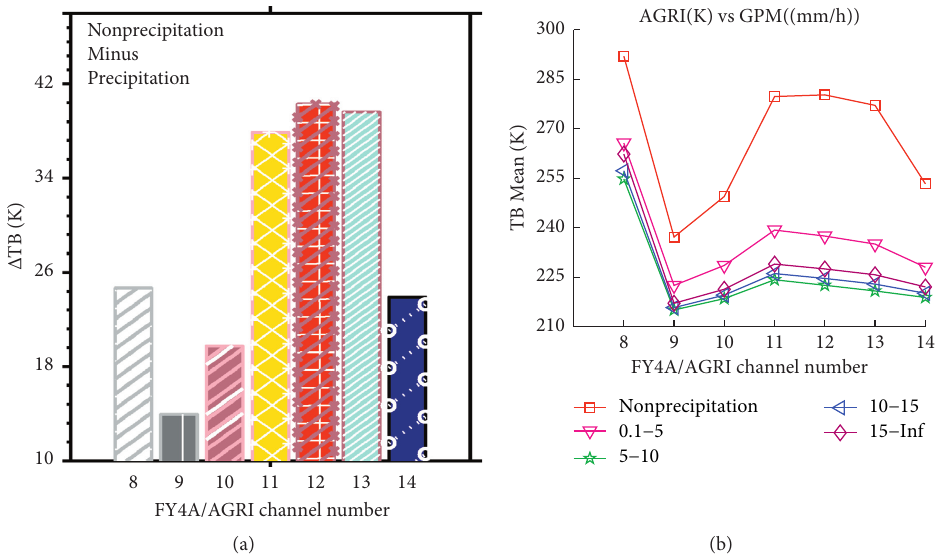
Figure 1: Brightness temperature gradient of nonprecipitation and precipitation (a) and brightness temperature average of different precipitation grades (b).